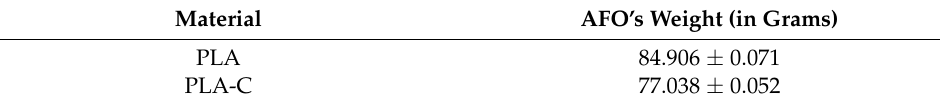
Table 3. Weight of 3D-printed AFOs.